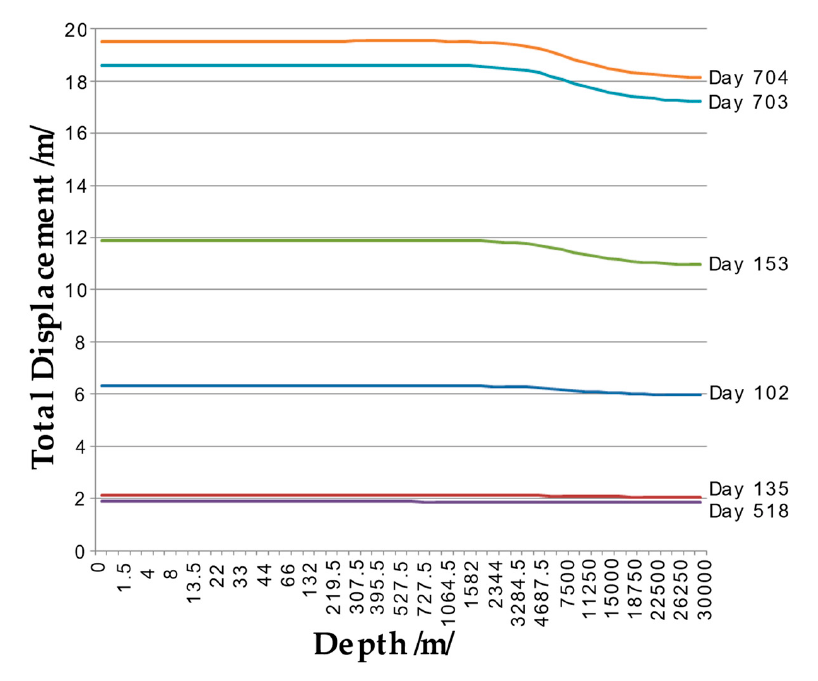
Figure 10. Depth pro fi le of total displacement /mm/ between sections 1 and 2 of Figure 3 ( φ = 0°).